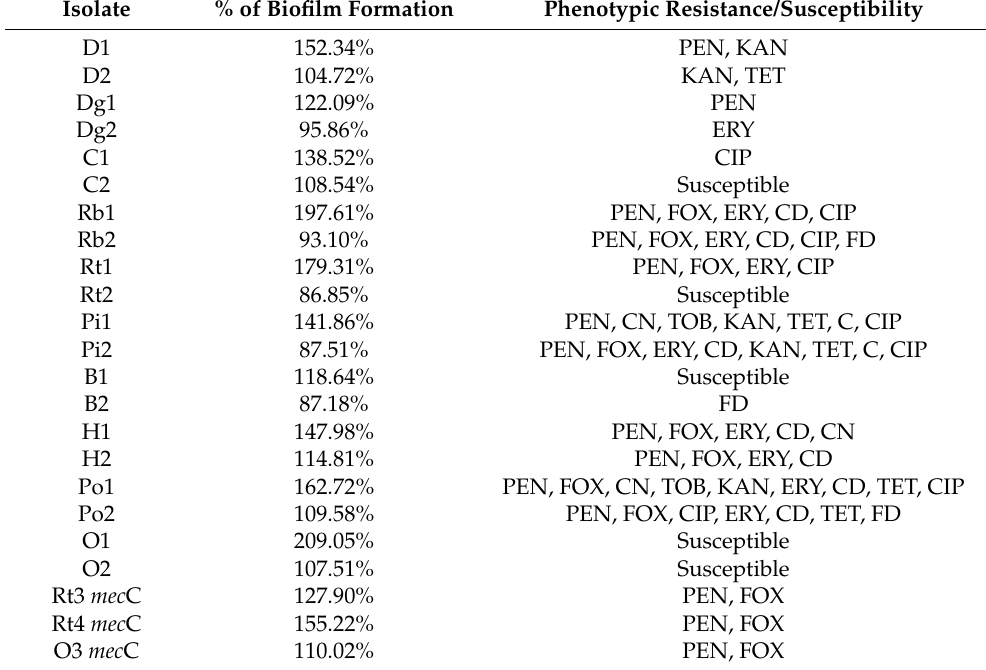
Table 1. Biofilm-forming capacity and susceptibility to antimicrobials of the 23 selected strains. Isolate % of Biofilm